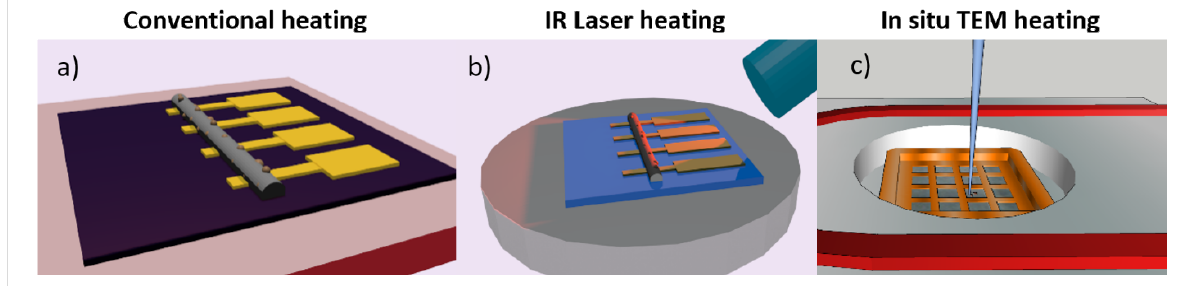
Figure 1: Sketch of post-growth annealing experiments: a) conventional heating using a hot plate in an SEM, b) SEM integrated laser heating; the substrate is heated by the IR laser pulses, c) post-growth thermal annealing during in situ TEM analysis. Conventional and IR laser annealing experi- ments were combined with in situ four-point probe resistance